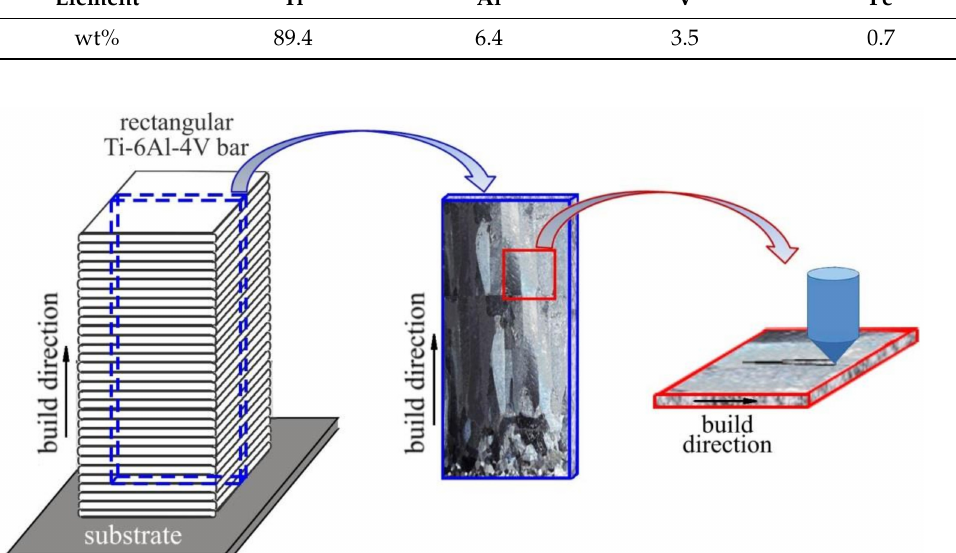
Figure 1. Schematic of cutting a sample from an as-built EBAM Ti-6Al-4V bar and its scratch